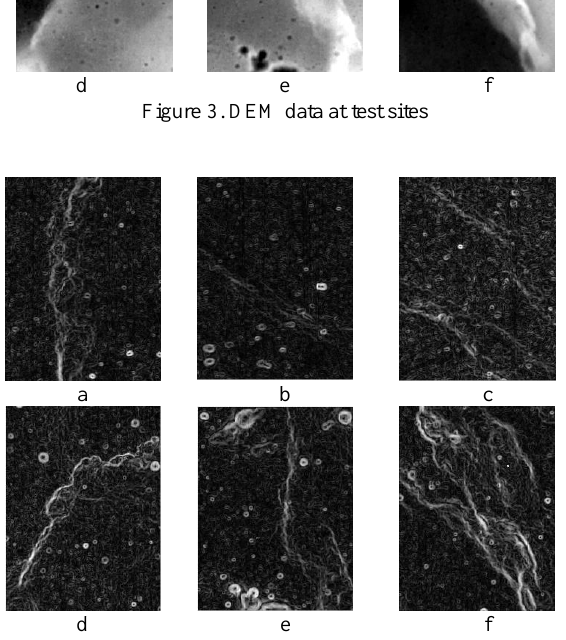
Figure 4. Slope map of lunar ridges at test sites